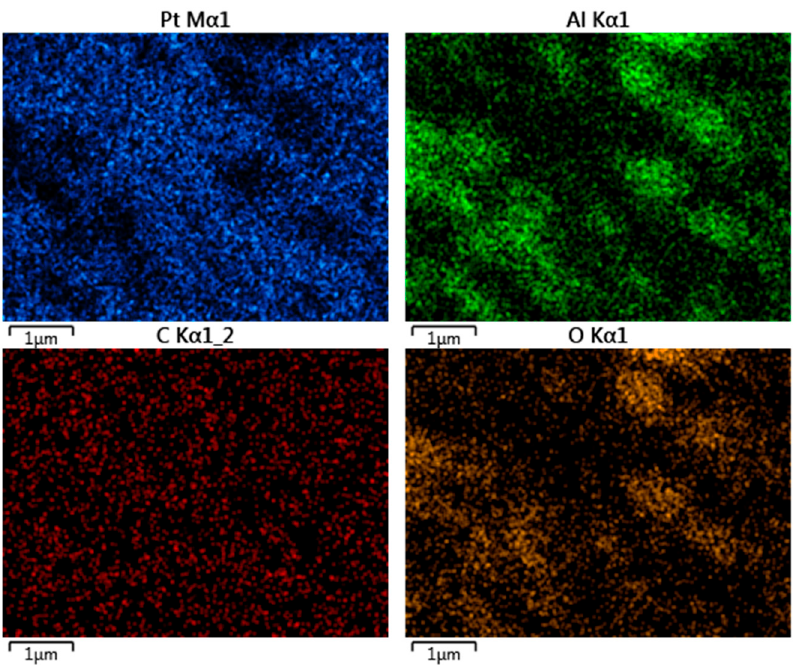
Figure 2. Pseudo ‐ color map of the relative distribution of different elements on the EDS analyzed surface. Blue—platinum; green—aluminum; red—carbon, yellow—oxygen. Pt and Al distribution are complementary. Note that Al and O overlap, suggesting Al ‐ O as a substrate for the Pt overcoat. Uniform distribution of C is in line with contamination.